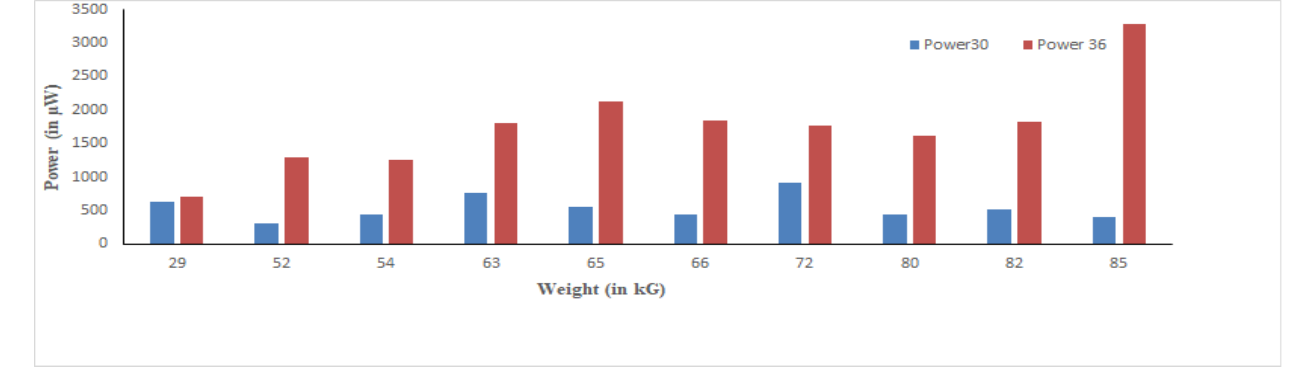
Figure 6. Actual power analysis using 30 and 36 sensors for different subject weights .